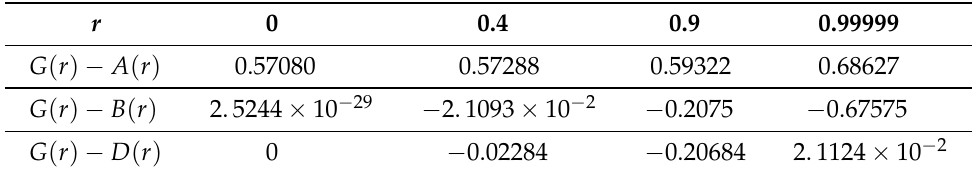
Table 1. The error table between K ( r ) and G ( r ) r 0.2 0.4 0.8 0.9 K ( r ) − G ( r ) Table 2. The error tables between G ( r ) and A ( r ) , B ( r ) , D ( r ) r 0 0.4 0.9 0.99999 G ( r ) − A ( r ) 0.57080 0.57288 0.59322 0.68627 G ( r ) − B ( r ) 2. 5244 × 10 − 29 − 2. 1093 × 10 − 2 − 0.2075 −